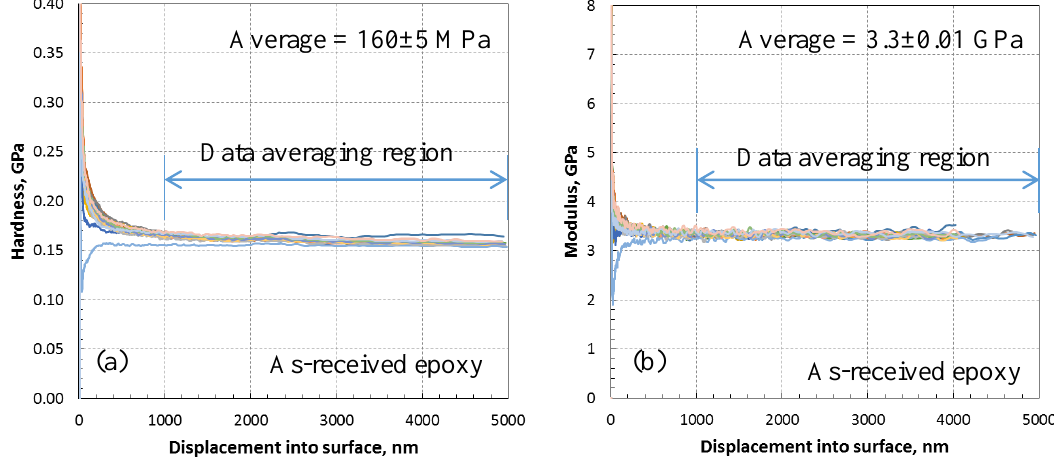
Figure 5. Nanoindentation data of as-received (0 wt % CNP) epoxy; ( a ) variation of hardness with depth showing steady hardness after 1 micron indentation with average hardness of 160 ± 5 MPa, ( b ) variation of modulus with depth showing steady modulus after 1 micron indentation with an average modulus of 3.3 ± 0.01 GPa.